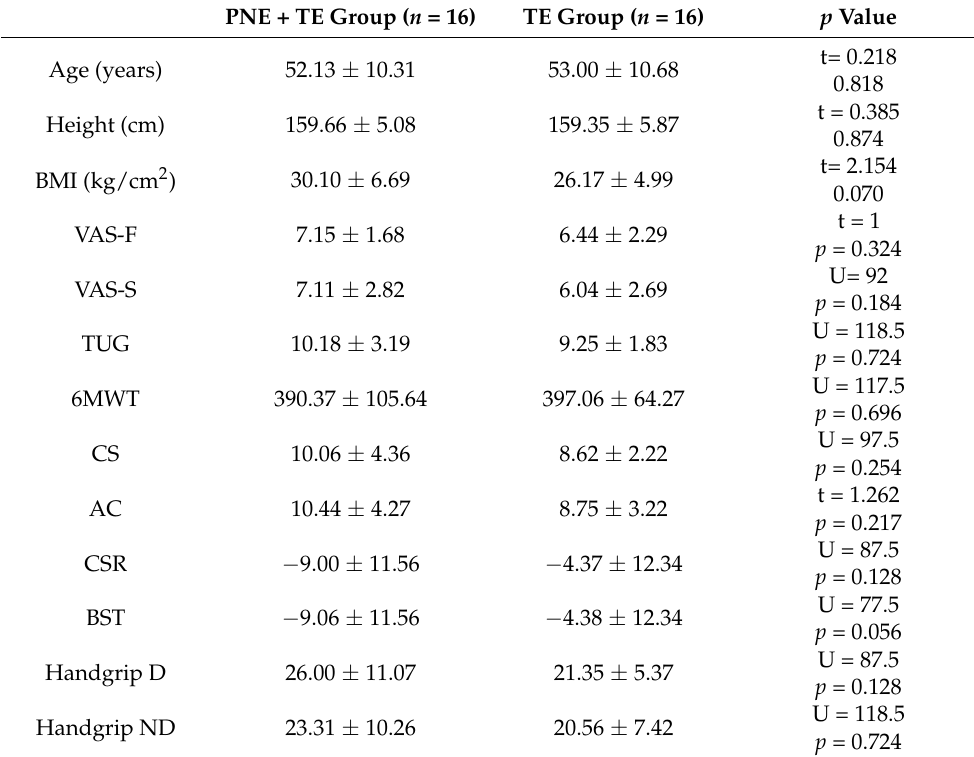
Table 1. Baseline sociodemographic data.